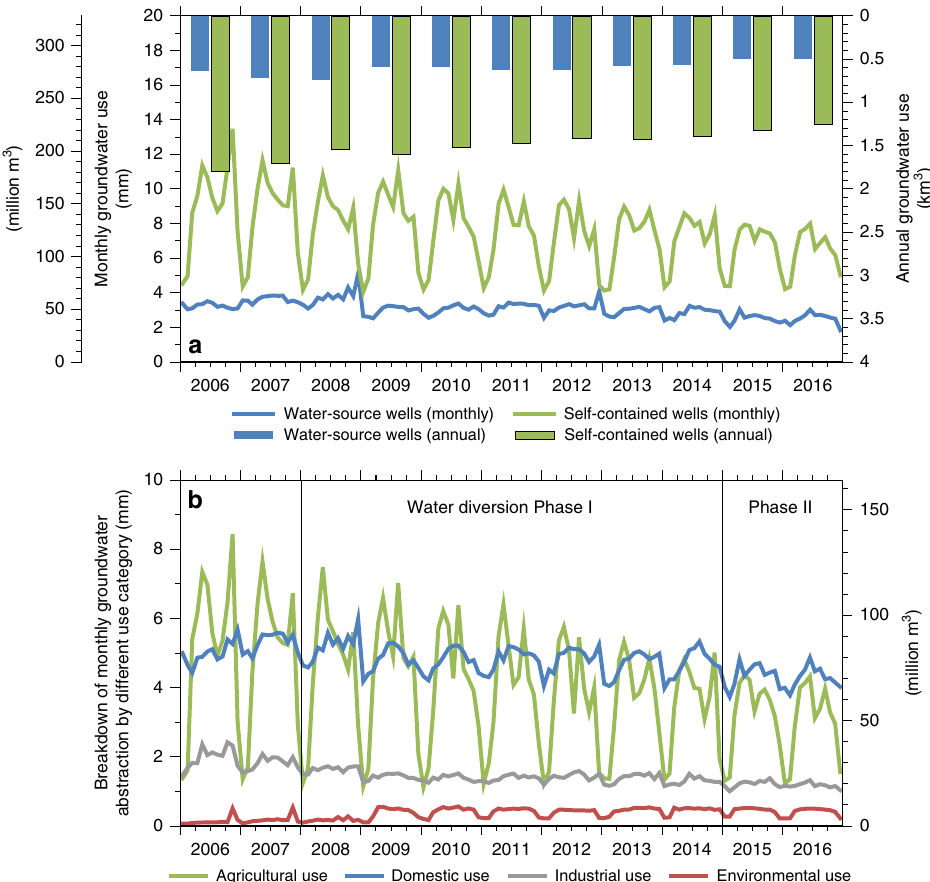
Fig. 3 Groundwater use and its breakdown in Beijing for 2006 – 2016. a Monthly and annual GW use, including self-contained wells that mainly supply water for agricultural and domestic use, and water-source wells that mainly supply water for domestic and industrial use. b Breakdown of monthly GW abstraction by different use categories in Beijing during 2006 ‒ 2016, including agricultural, domestic, environmental, and industrial use.